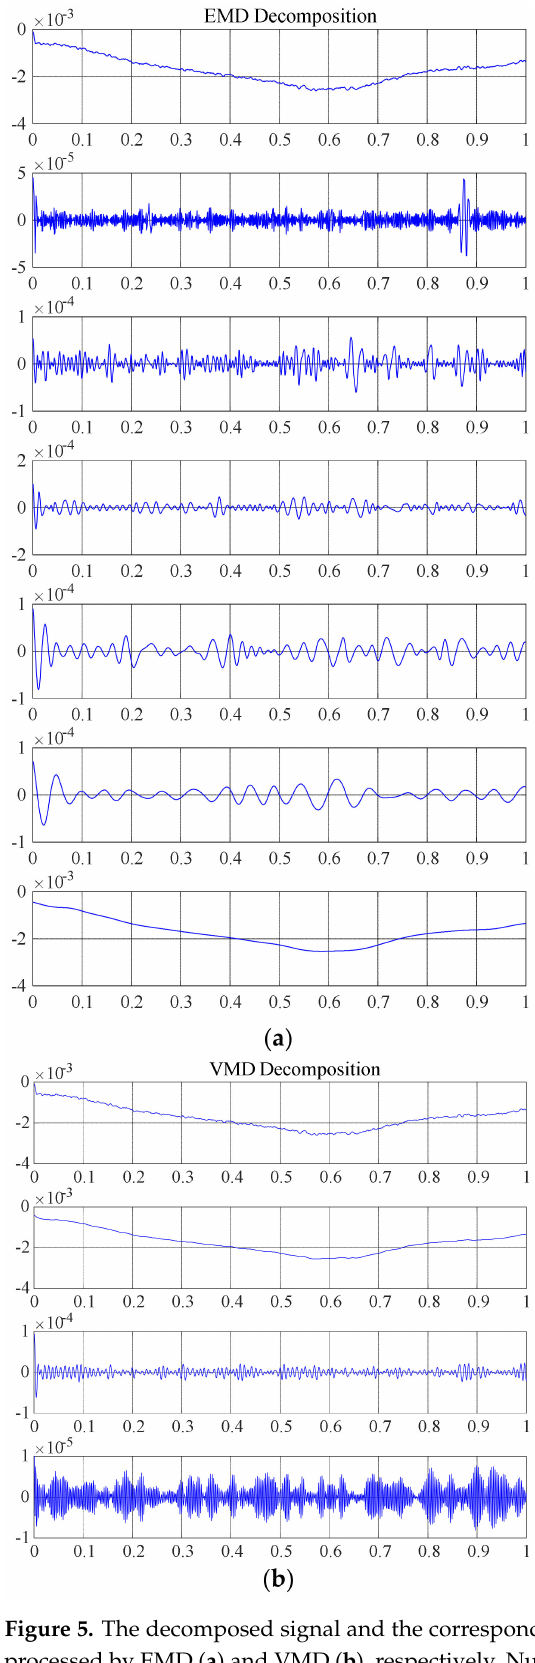
Figure 5. The decomposed signal and the corresponding spectrum of the sound signal (Sample 1) processed by EMD ( a ) and VMD ( b ), respectively. Number of samples on the x -axis, magnitude on the y